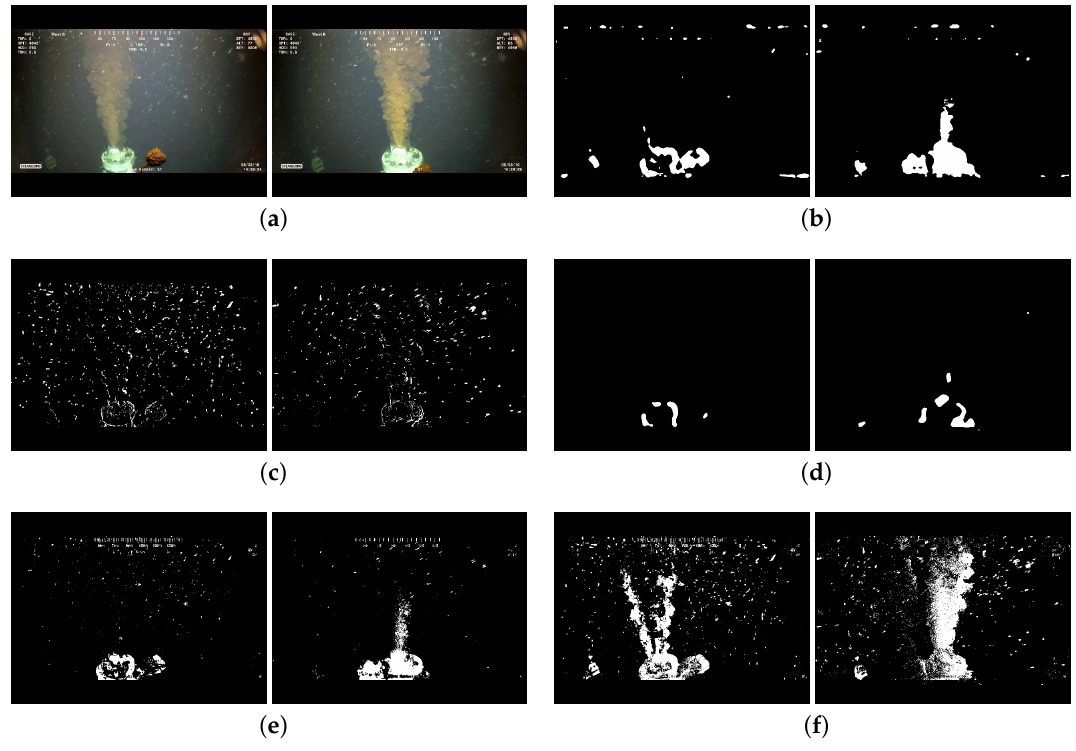
Figure 4. Foreground detection: ( a ) original frame; ( b ) LOBSTER [26]; ( c ) MOG2 [17]; ( d ) SuBSENSE [27]; ( e ) VIBE [28]; and ( f ) T2FGMG-UV.